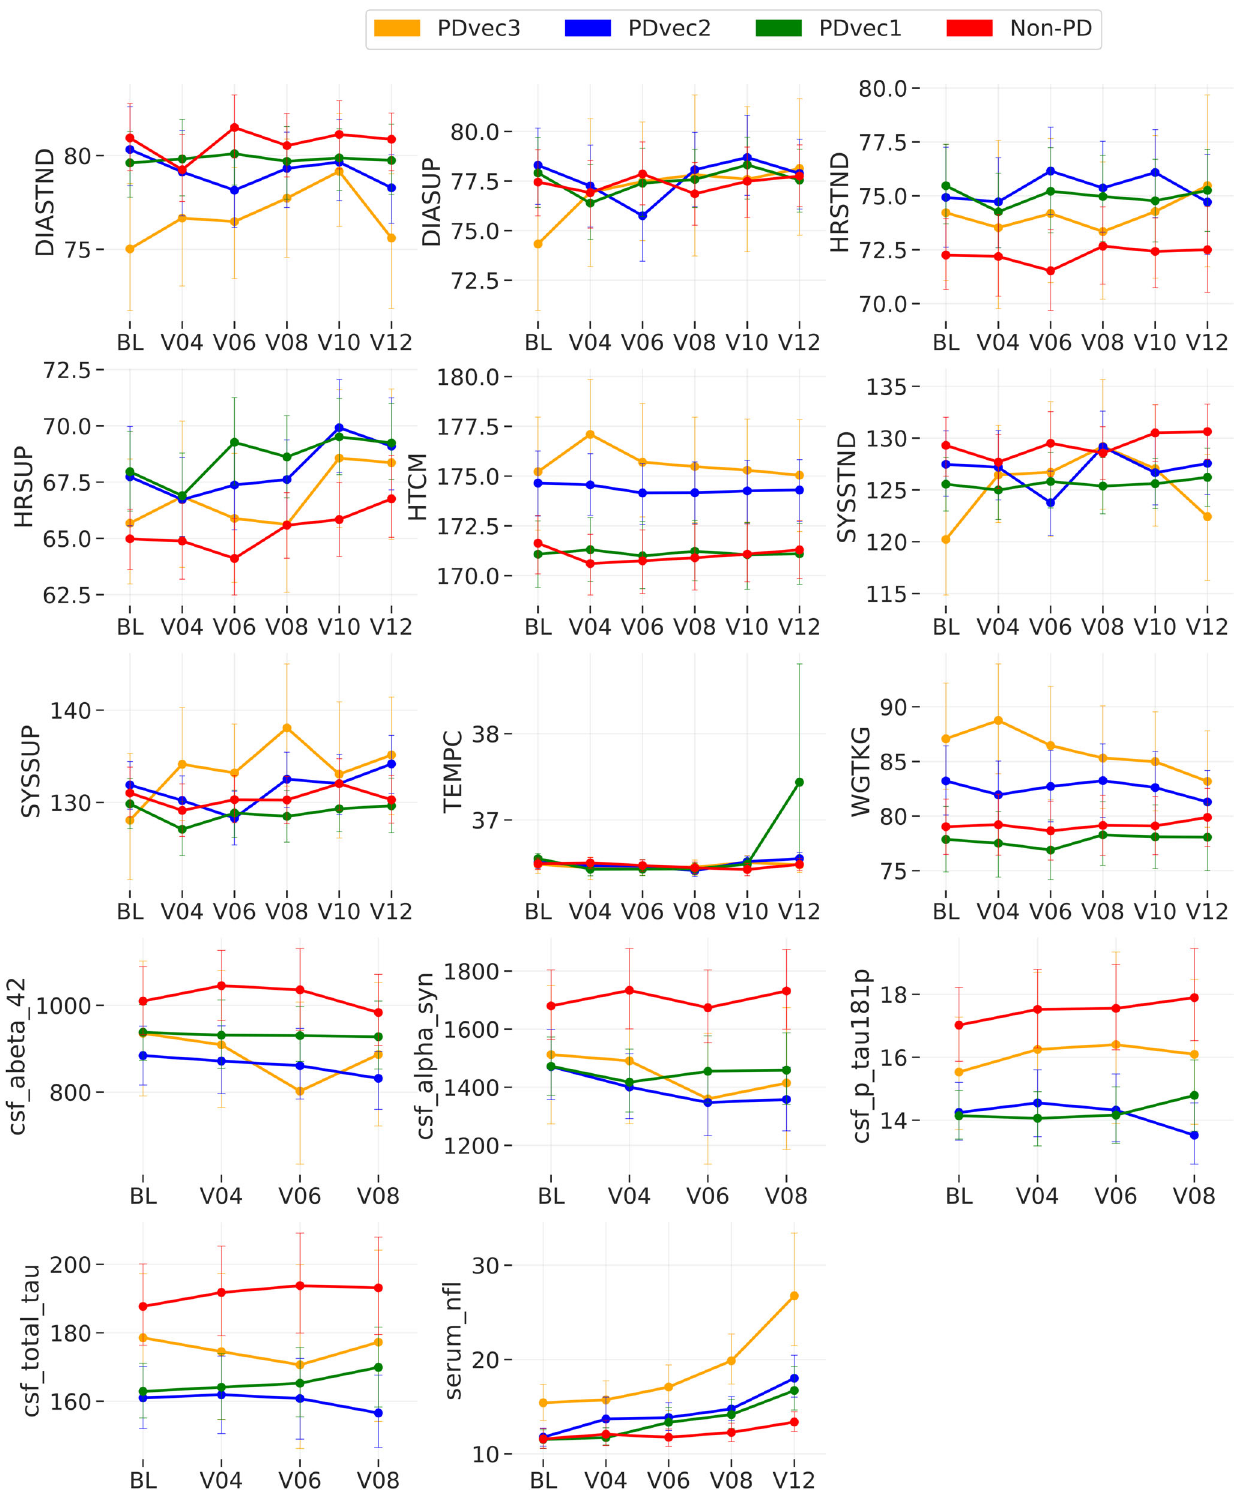
Fig. 4 Shows the biological biomarker variation of each PD subtype over time. The graphs demonstrate the actual clinical values of each subtype overtime for vital signs (DIASTND standing diastolic blood pressure (BP), DIASUP supine diastolic BP, HRSTND standing heart rate, HRSUP supine heart rate, SYSSTND standing systolic BP, SYSSUP supine systolic BP, HTCM height in cm, TEMPC: temperature in C, WGTKG weight in kg), cerebrospinal fl uid (abeta_42 β -amyloid 1 – 42, alpha_syn alpha-synuclein, p_tau181p phospho-tau181, total_tau total tau protein), and serum neuro fi lament light levels (serum_n fl ). BL: Baseline. V04 visit number 4 after 12 months. V06: visit number 6 after 24 months. V08 visit number 8 after 36 months. V10 visit number 10 after 48 months. V12 visit number 12 after 60 months. In all panels, data is presented as mean ±